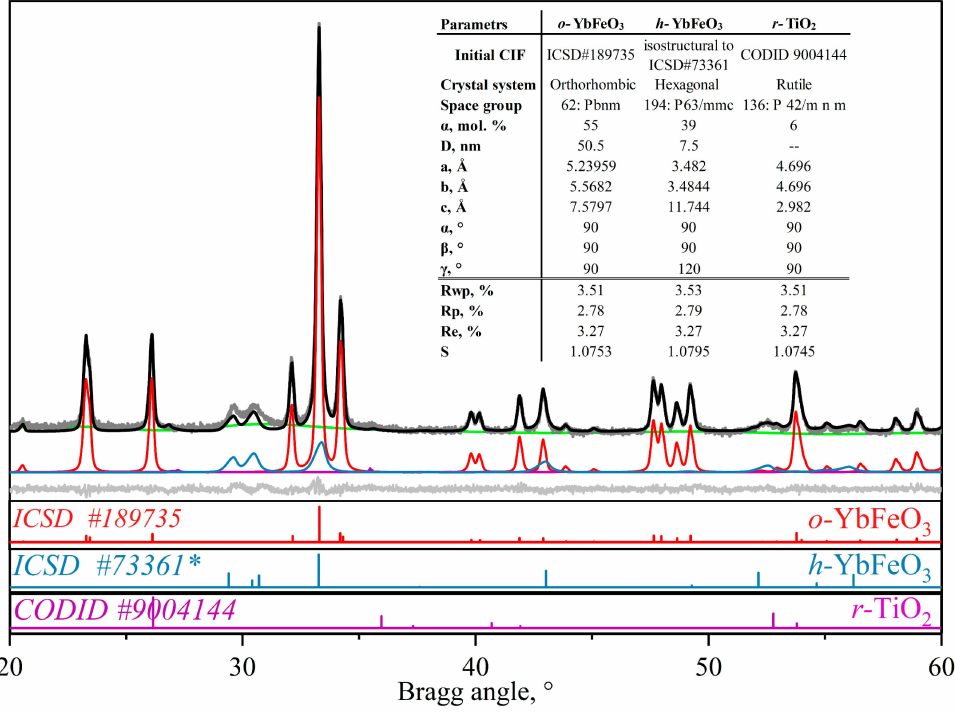
Figure 4. Rietveld refinement results for the X-ray diffraction of o -YbFeO 3 / h -YbFeO 3 / r -TiO 2 - 5%. According to PXRD data, the dependences of the degree of conversion of the